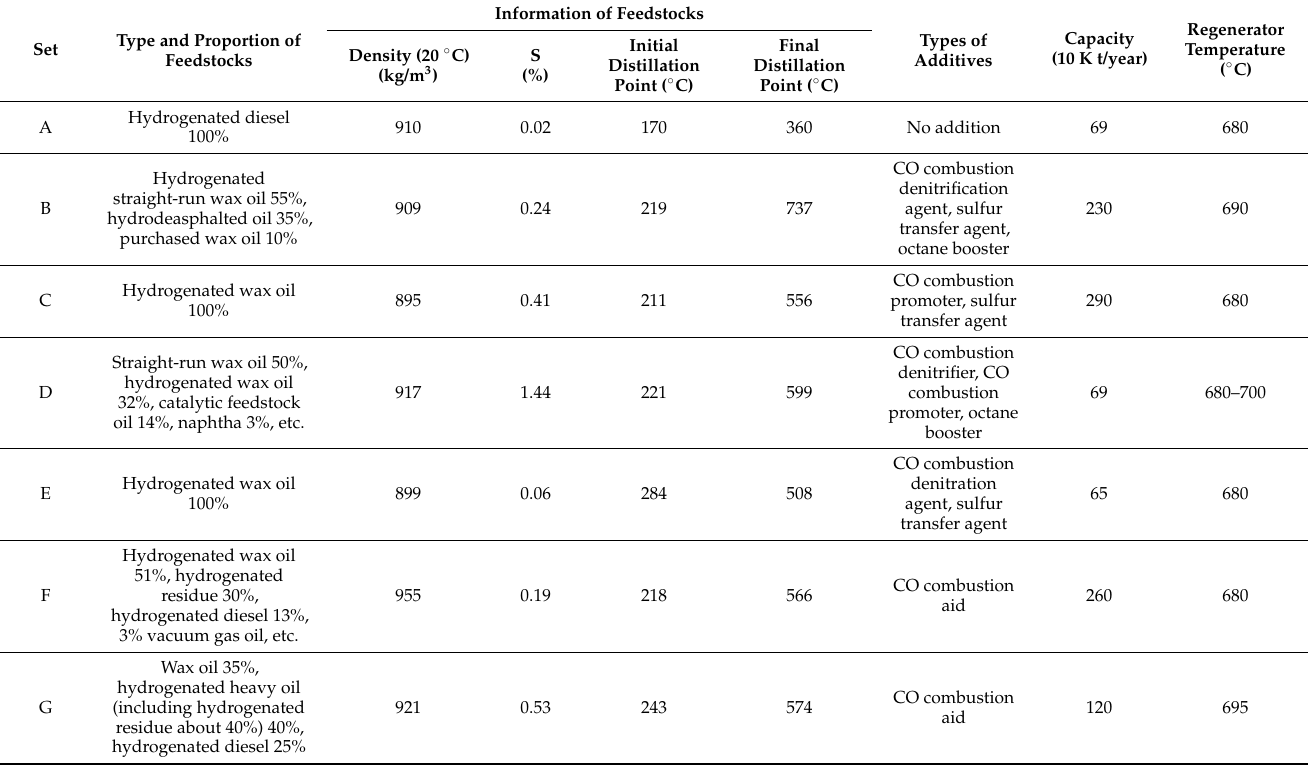
Table 6. Characteristics of catalytic cracking units